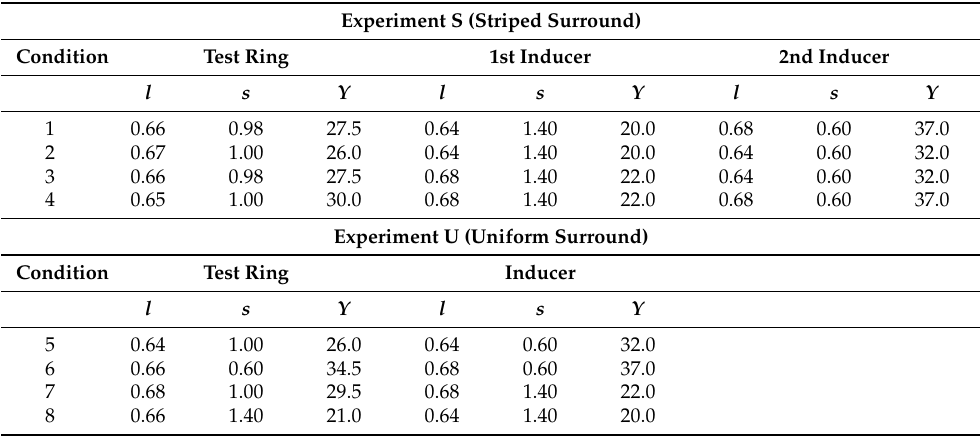
Table 1. Colours used in the experiments. Chromaticities are defined in the MacLeod–Boynton colour space, with s normalised to unity equal-energy white